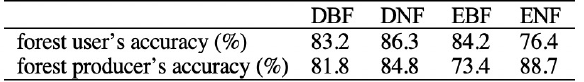
Table 2 represents a summary of FU and FP. All values in FU for four forest types except the ENF class are larger than those in FP, suggesting that these forest classes in the classification map tend to be identified at the reference points correctly well, compared to that in the reference against the classification map. The ENF class shows the opposite pattern. The FO is 82.2%.